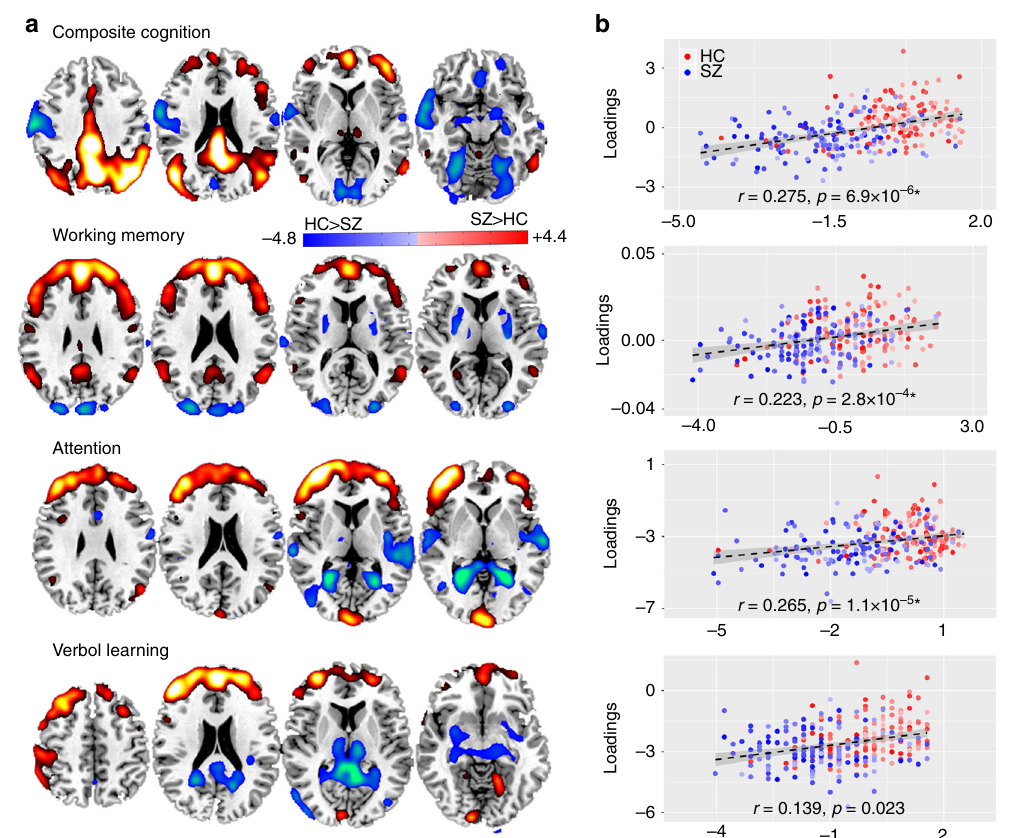
Fig. 6 Spatial maps of fALFF activations for four main CMINDS cognitive domains. a The brain maps of fALFF FBIRN_IC ref associated with composite, working memory, attention and verbal learning domains respectively that are visualized at | Z | > 2. The positive values (red) means SZ < HC and the negative values (blue) means SZ > HC. b Correlations between loadings of fALFF component and its associated CMINDS domain scores after controlling for diagnosis (HC: the red dots, SZ: the blue dots); the higher loadings correspond to better cognitive performance. The gray regions in b indicate a 95% con fi dence